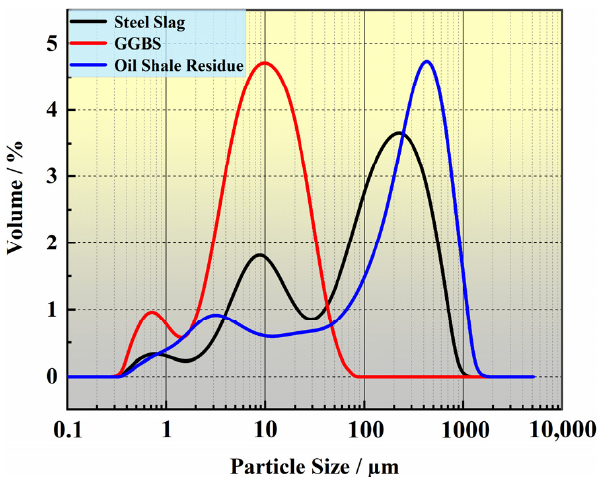
Figure 2. Particle size curves of the OSR, SS and GGBS.